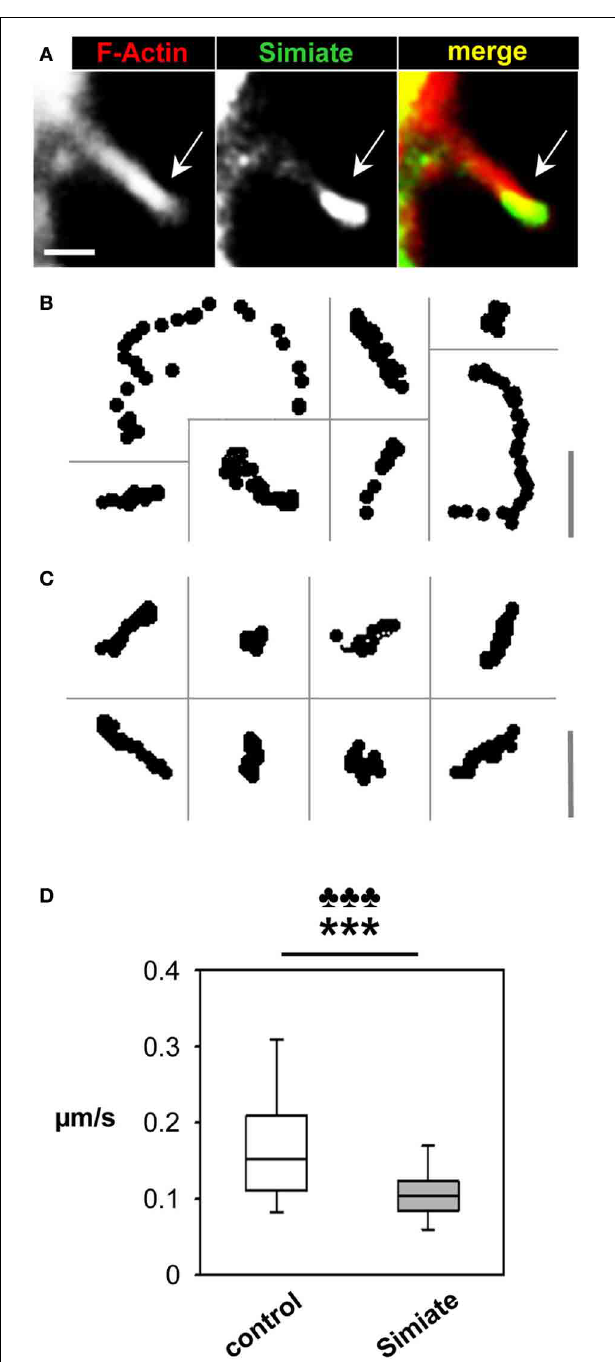
FIGURE 4 | Simiate affects filopodia dynamics. (A) Colocalization of GFP-Actin and Lifeact-RFP labeled F-Actin in a filopodium protruding from a HEK-293 cell. Please note the accumulation of GFP-Simiate at the tip of the filopodium (arrow). In order to visualize the shaft of the filopodium as well, a picture with a higher gain is shown, resulting in signal saturation at the filopodia head. Scale bar: 2 μ m. (B) Representative tracks of filopodia tips from GFP and Lifeact-RFP coexpressing HEK-293 cells. Scale bar: 3.5 μ m. (C) Representative tracks of filopodia tips from GFP-Simiate and Lifeact-RFP coexpressing HEK-293 cells. Scale bar: 3.5 μ m. (D) Quantification of filopodia head movements. The p -value of the F -test is represented by clubs, whereas the p -value of the U -test is shown as